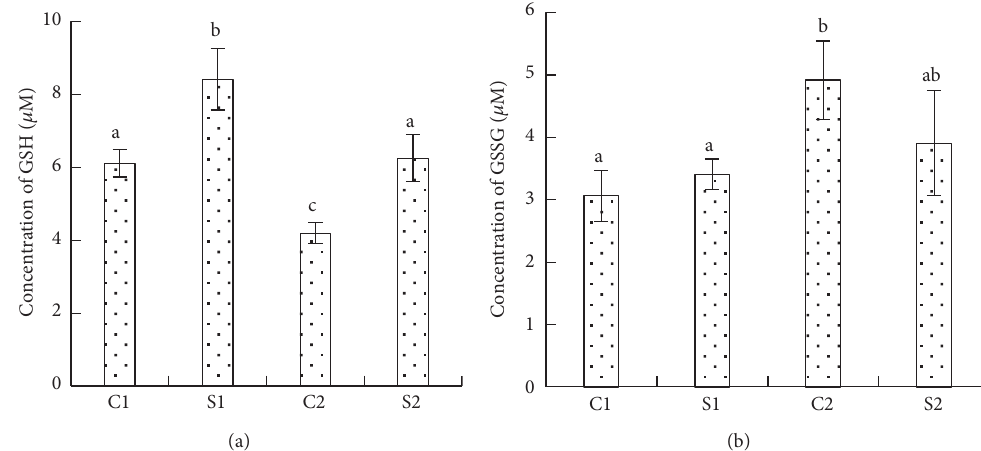
Figure 5: Effects of MKAVCFSL on the cellular GSH and GSSG. (a) GSH concentration. (b) GSSG concentration. C1: control 1, medium treatment without H 2 O 2 and peptide; S1: sample 1, peptide treated only; C2: control 2, H 2 O 2 treated only; S2: sample 2, medium treatment with H 2 O 2 and peptide. Results are the means ± SD from three independent experiments. Different small letters indicate significant differences between groups ( p < 0 . 05).